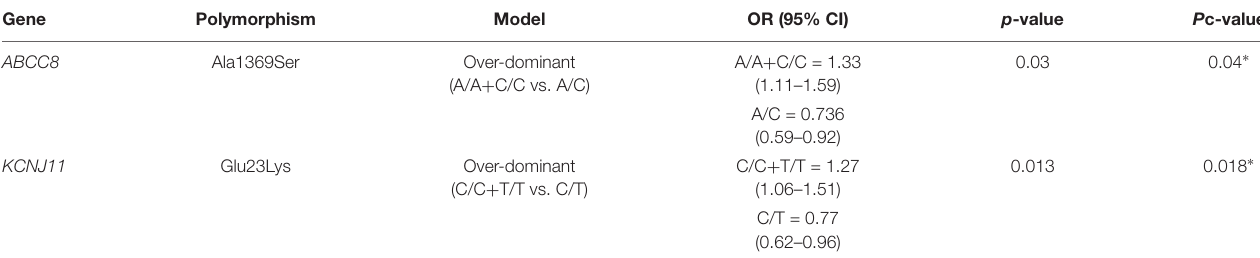
TABLE 4 | Association values between genotypes and response using dominant, over-dominant, and additive models.